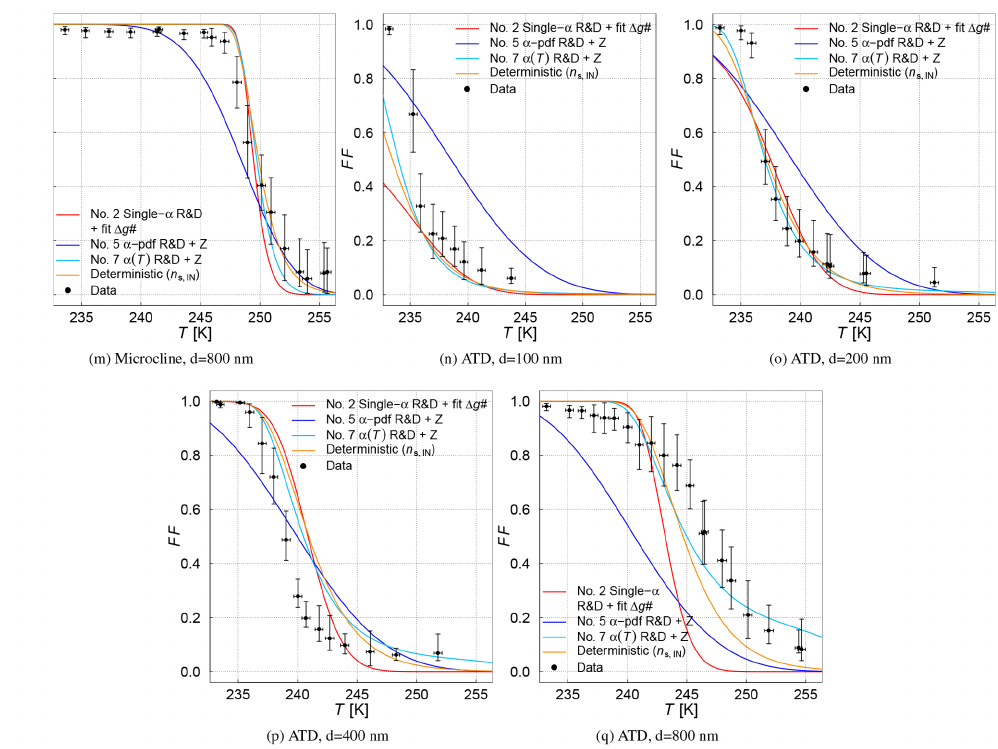
Figure 6. Calculated FF of illite (a–d) , montmorillonite (e–h) , microcline (i–m) , and ATD (n–q) after a residence time t of 10s for certain sizes using the single- α R&D + fit (cid:49)g # formulation (CNT2), the α -pdf R&D + Z formulation (CNT5), and the α(T ) R&D + Z formulation (CNT7) with corresponding fit parameters (see Table 2). A simplified immersion freezing parameterization scheme based on Niemand et al. (2012) is additionally compared to the